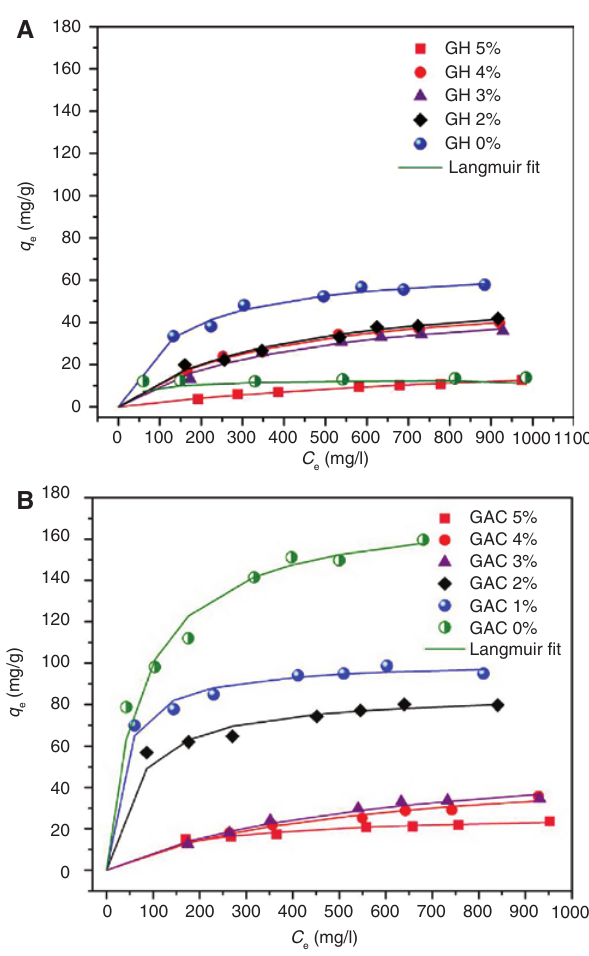
Figure 7: Adsorption isotherms of phenol by various (A) glucose hydrochar and (B) activated carbon (AC) samples.